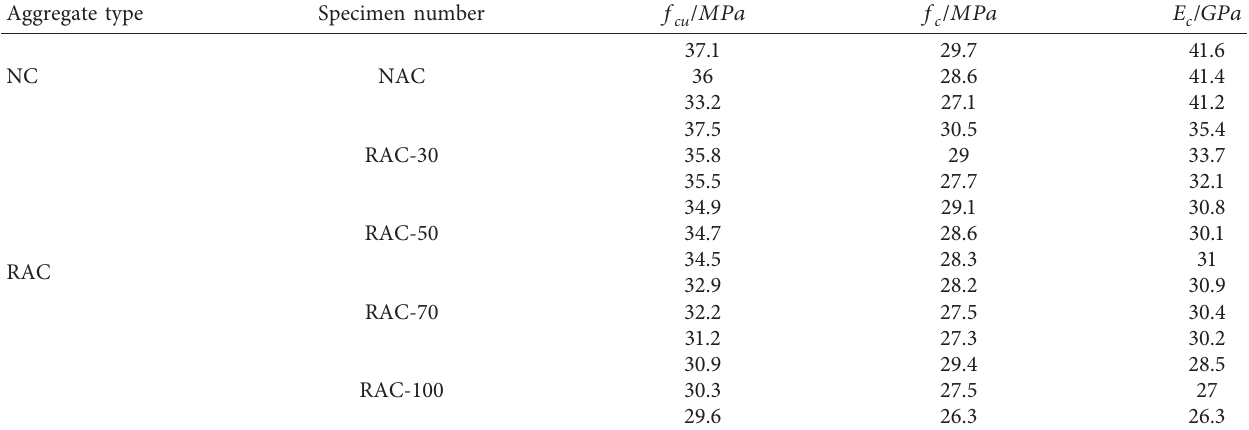
Table 8: Basic test